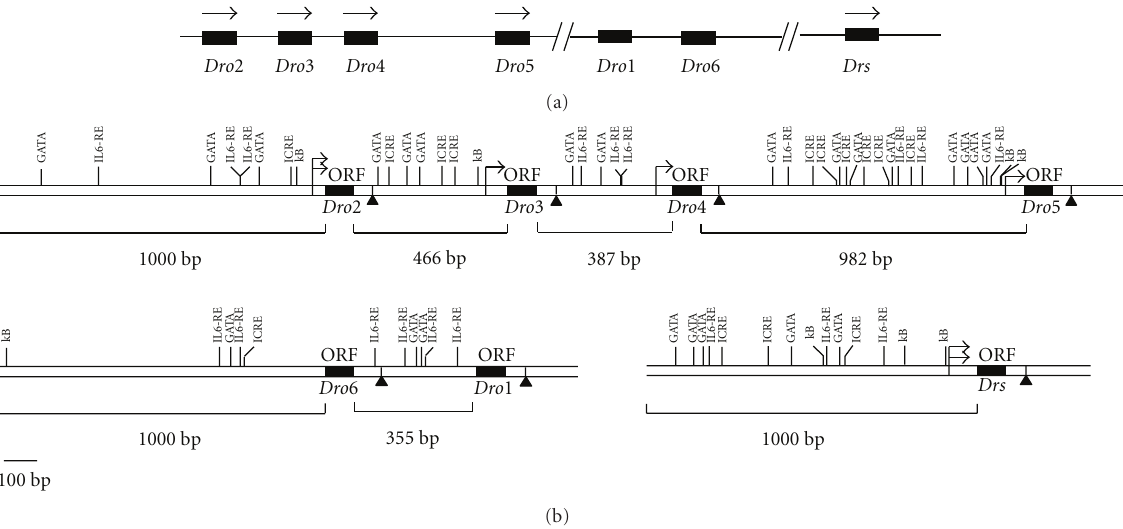
Figure 4: The schematic organization of the transcription factor binding sites upstream drosomycin genes in D. melanogaster. (a) General position of drosomycin genes on the 3L chromosome. (b) Organization of binding sites for putative transcription factors at the upstream region of drosomycin genes. κ B: NF- κ B site, GGGRAYYYYY of consensus sequence (there was no sites with perfectly matched sequence of GGGRAYYYYY. Sites with one nucleotide mismatch were given in the figure); GATA: binding site of the GATA factor, WGATAR of consensus sequence; IL-6 RE: sites for interleukin-6 response element with TKNNGNAAK of consensus sequence; ICRE: sites for interferon consensus element with GGAAANN of consensus sequence. Black boxes indicated ORFs of drosomycin genes. Arrows indicated transcription start sites (TSSs) and arrows with double heads represented double TSSs. Bolded triangle ( (cid:2) ) indicated polyadenylation signal.